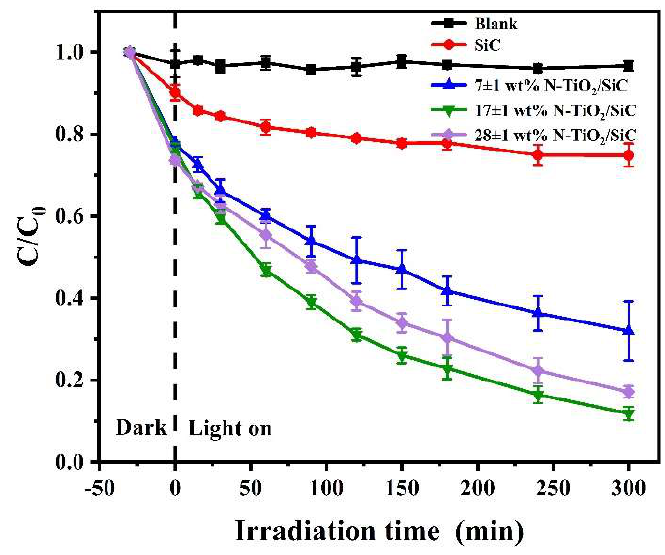
Figure 8. Effect of catalyst loading on MB photodegradation.